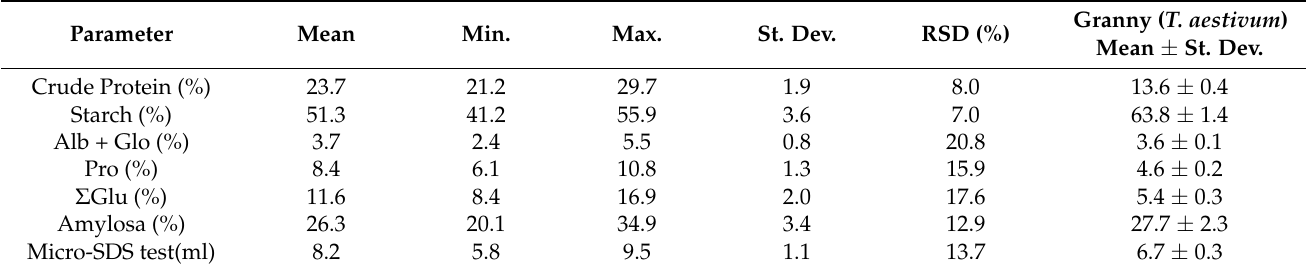
Table 3. Variability of seed composition in 7 selected populations of Dasypyrum villosum and spring wheat cultivar Granny ( T. aestivum L) in tested years: 2008, 2009 and 2011.